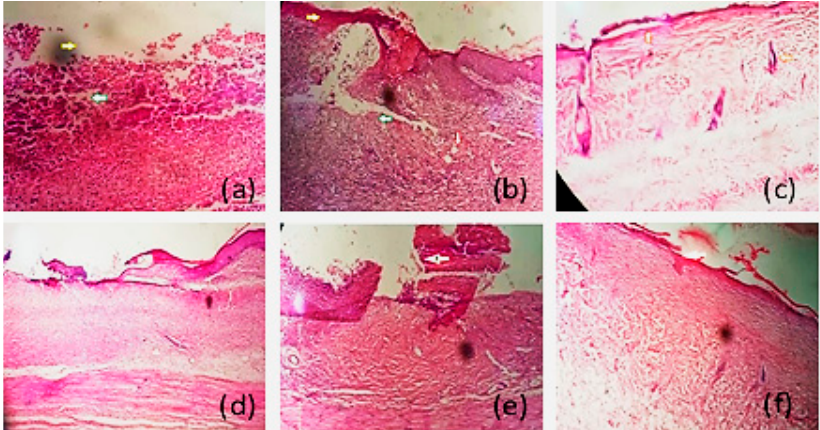
Figure 8. Histopathological examination of different formulations, skin denudation, and inflamma- tion of R1 ( a , b ), skin regeneration of R2 ( c ), fibrosis of R3 ( d ), fibrosis and regeneration of R4 ( e ), and skin epithelization of R5 ( f ).